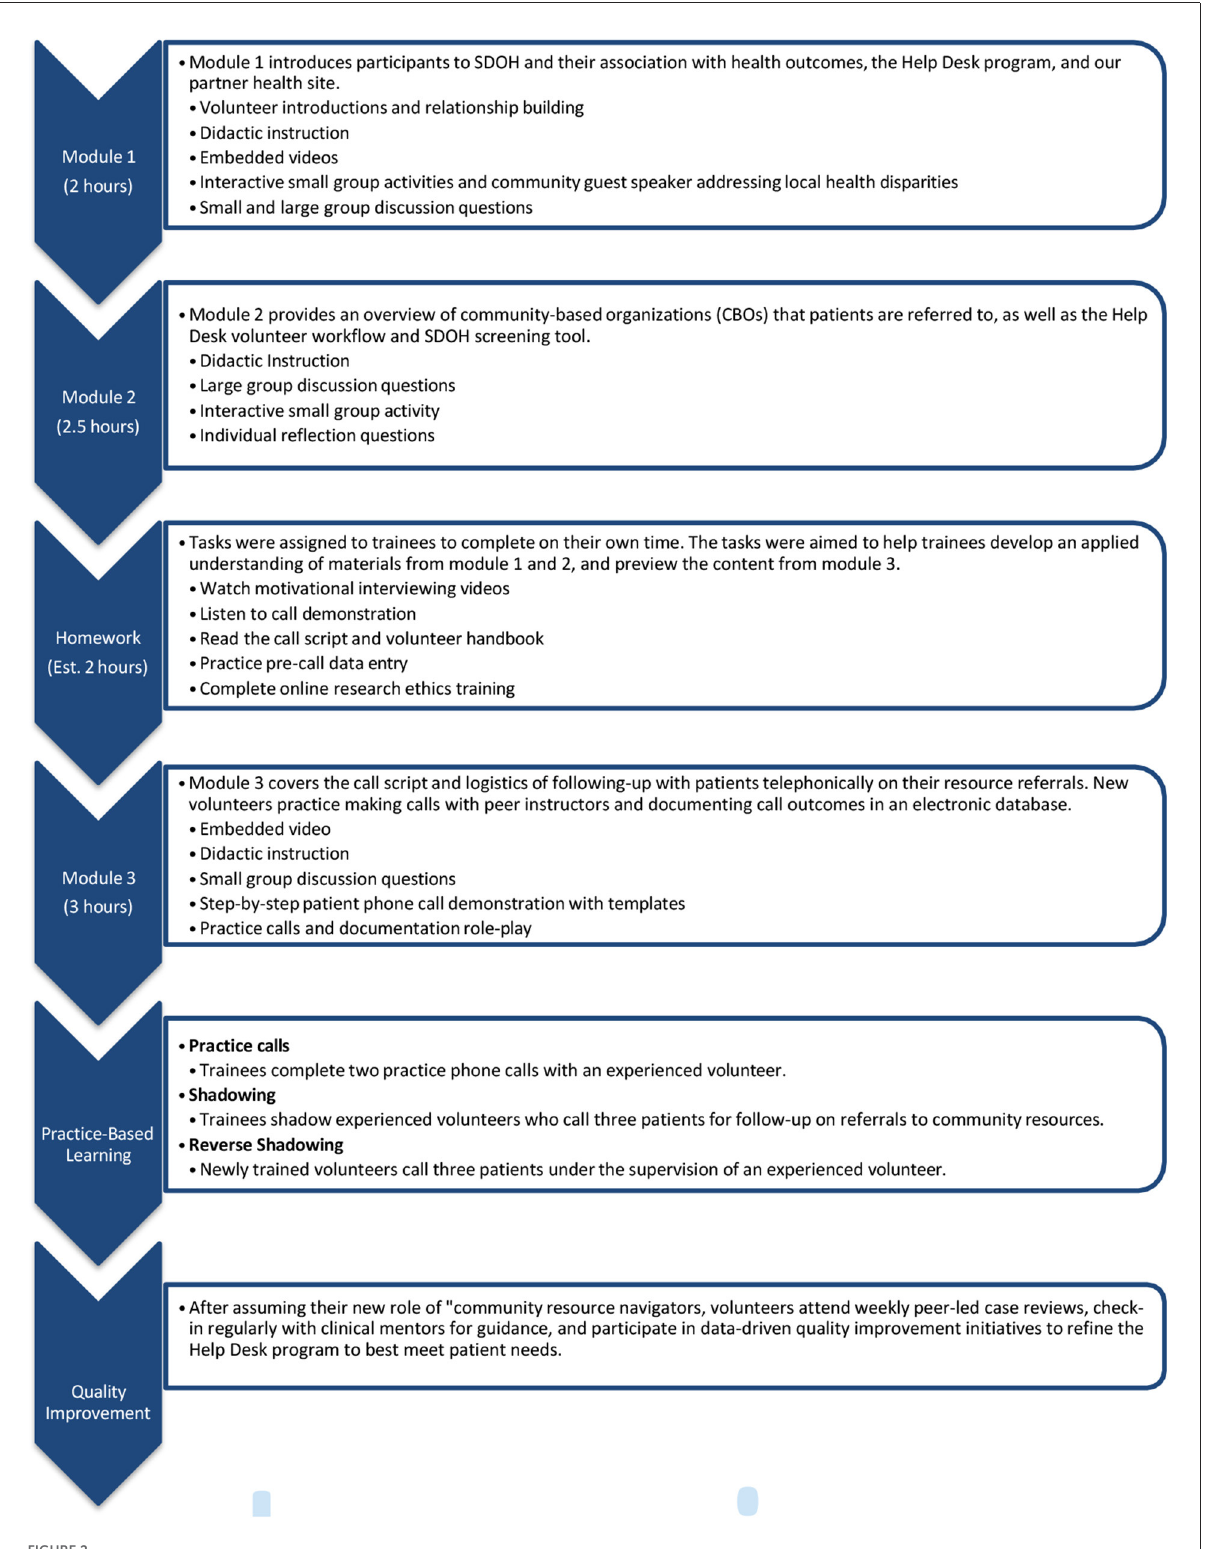
FIGURE2 Help desk training